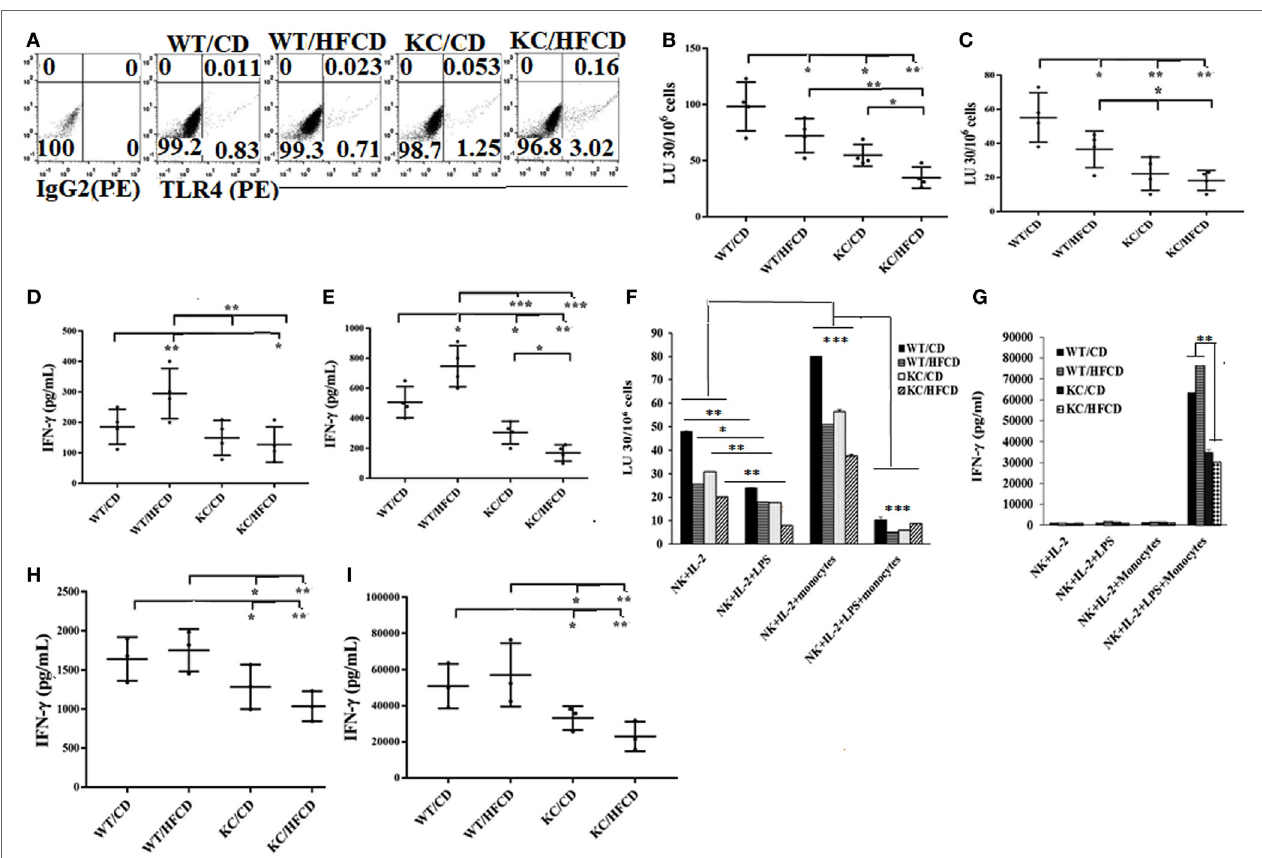
FigUre 1 | Natural killer (NK) cells from KC mice fed with control diet (CD) or high-fat calorie diet when cultured with autologous monocytes demonstrated less cytotoxicity and decreased IFN- γ secretion when compared to WT mice fed with CD. WT and KC mice were fed with a CD or high-fat calorie diet as described in Section “Materials and Methods.” Splenocytes were harvested after animals were sacrificed and single cell suspension was prepared as described in Section “Materials and Methods” and used to purify NK cells. TLR4 surface expression on the purified NK cells from four groups of mice was analyzed using antibody staining followed by flow cytometric analysis. One of three representative experiments is shown in the (a) . Purified NK cells from splenocytes were activated with IL-2 (10,000 U/ml) ( n = 4) (B,D) or with IL-2 (10,000 U/ml) in the presence of LPS (100 ng/ml) ( n = 4) (c,e) before they were used as effector cells in a standard 4-h 51 Chromium release assay. The lytic units (LUs) 30/106 cells were determined using the inverse number of NK cells required to lyse 30% of the ST63 cells × 100 ( n = 4) (B,c) , and the supernatants were harvested after culture to determine the levels of IFN- γ secretion ( n = 4) (D,e) . IL-2-treated and IL-2 and LPS-treated NK cells as described in (c,e) were cultured with or without autologous monocytes at NK:monocytes; 1:0.5 ratio before they were used as effector cells in a standard 4-h 51 Chromium release assay. The lytic units (LUs) 30/106 cells were determined using the inverse number of NK cells required to lyse 30% of the ST63 cells × 100. One of five representative experiments is shown in (F) . The supernatants were harvested to determine the levels of IFN- γ secretion. One of five representative experiments is shown in the (g) . IL-2-treated NK cells (h) and IL-2 and LPS-treated NK cells (i) were cultured with autologous monocytes